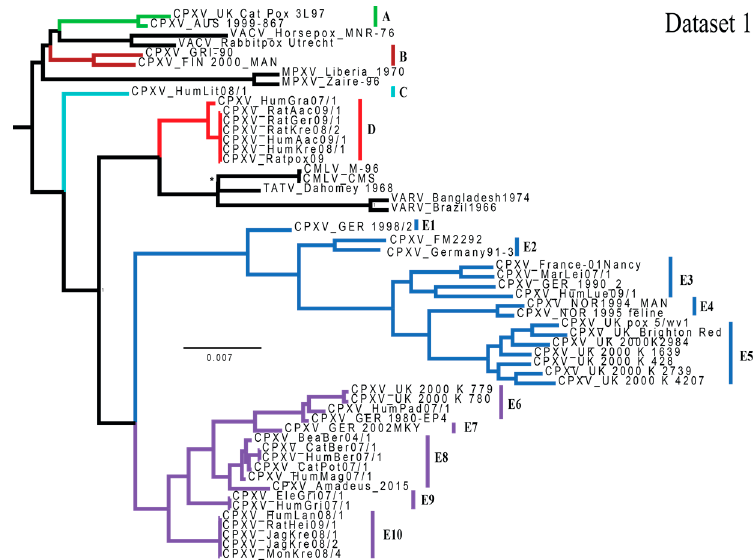
Figure 1. A majority-rule consensus tree generated from the MrBayes analysis of dataset 1 (150,718 bp). All Bayesian Posterior Probability (BPP) values were ≥ 0.95 with the exception of the Camelpox virus/Taterapox virus relationship, indicating high credibility of the branching (* BPP = 0.5181). Scale bar indicates the number of mutations per site. Clades are colored in the same manner as Dabrowski et al. [26]. Labels (A, B, C, D, E1–10) refer to monophyletic clades examined and discussed in the text. Outgroup is not pictured.